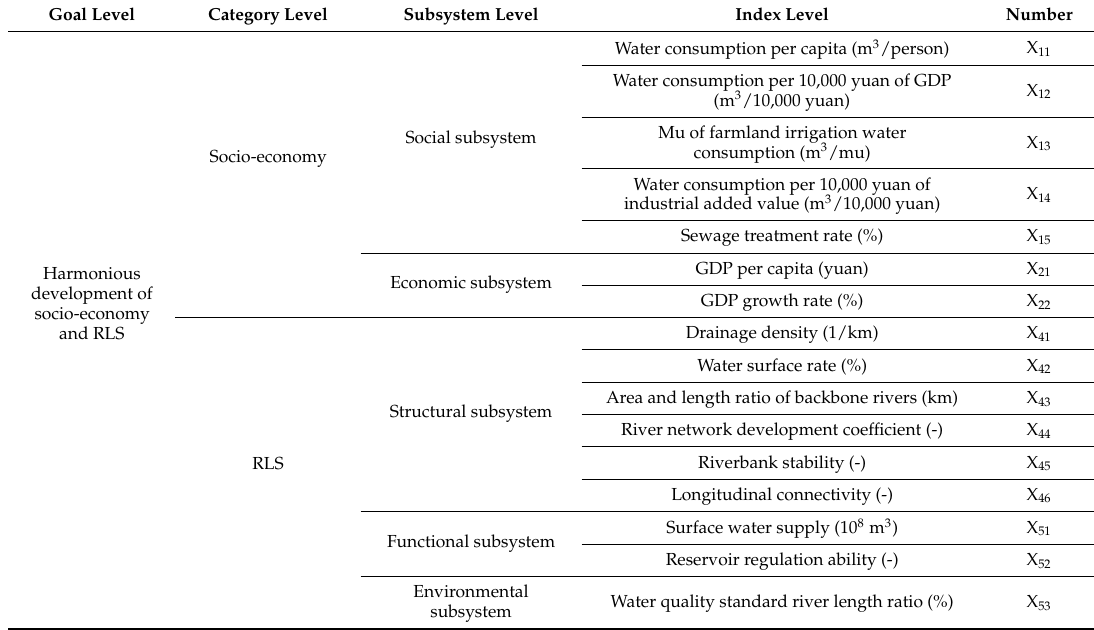
Table 2. Evaluation index system of harmonious development between socio-economy and